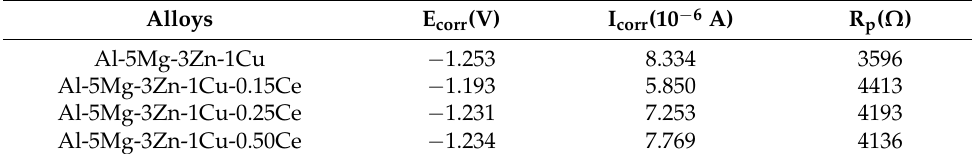
Table 4. The electrochemical parameters of Al-5Mg-3Zn-1Cu alloys with different Ce content.